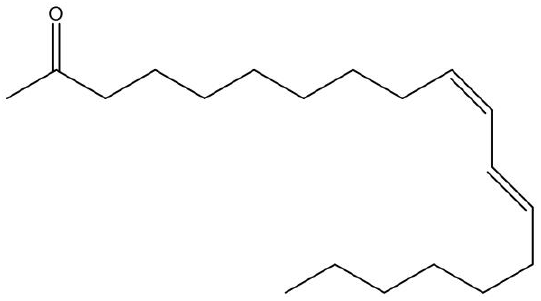
Figure 4. Molecular structure of methyl linoleate.